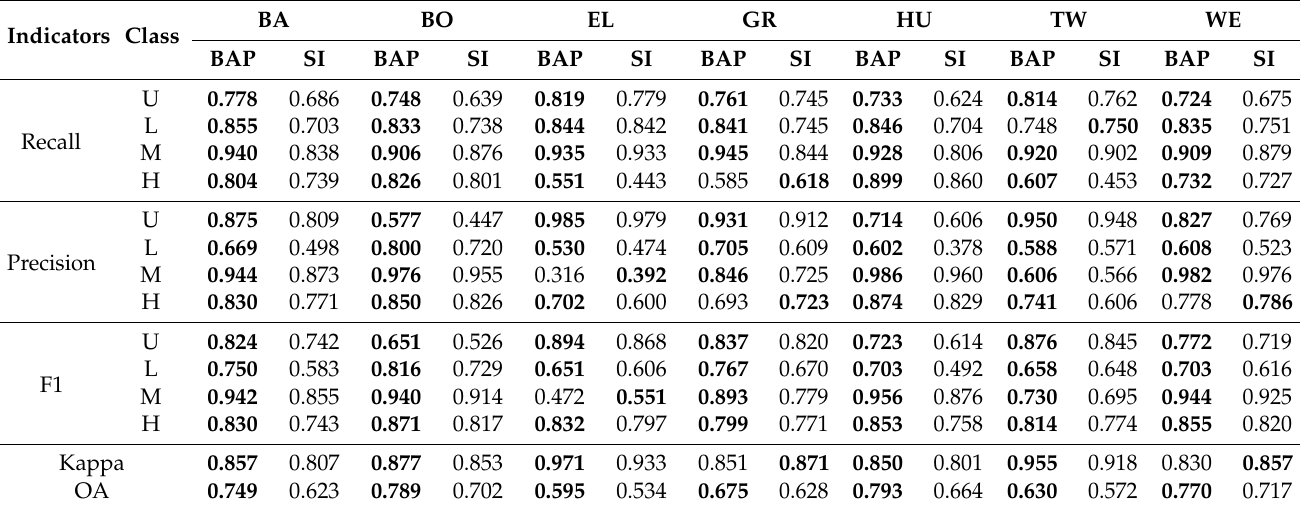
Table 4. Performance comparison of fire severity classification using BAP and SI methods for each fire within the northwestern continental US region. U: Unburned to Low; L: Low; M: Moderate; H: